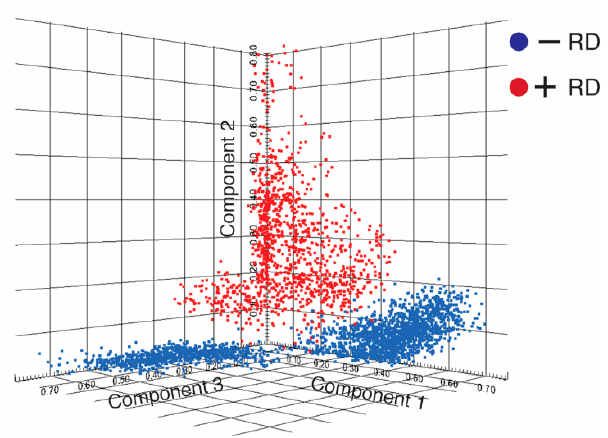
Figure 2. Discrimination of molecular signatures for the groups of HGSOC patients via probabilistic latent semantic analysis (pLSA). Score plots of the first three components from imaging mass spectrometry (IMS) spectra of primary tumors from patients without ( − RD, in blue) and with recurrent disease ( + RD, in red) are shown.